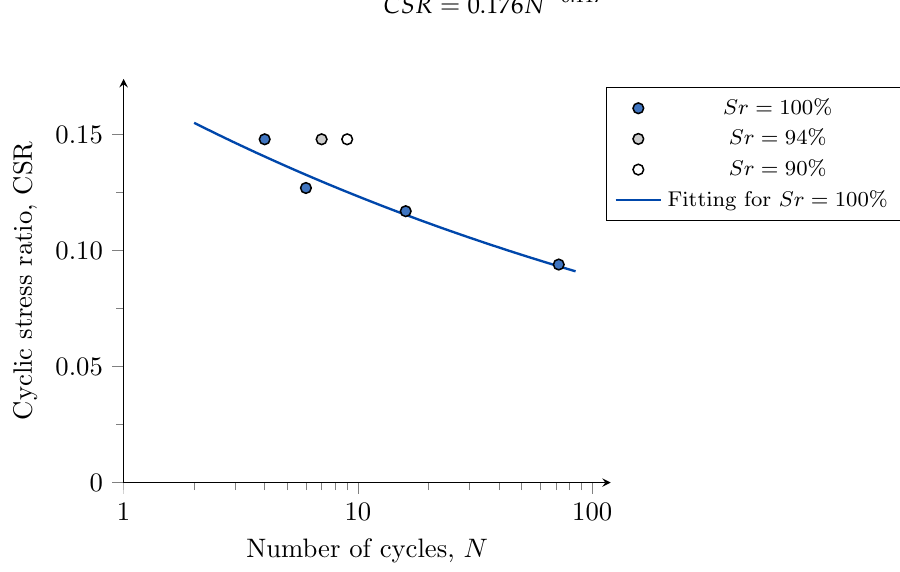
Figure 8. Results of cyclic stress ratio versus number of cycles to trigger